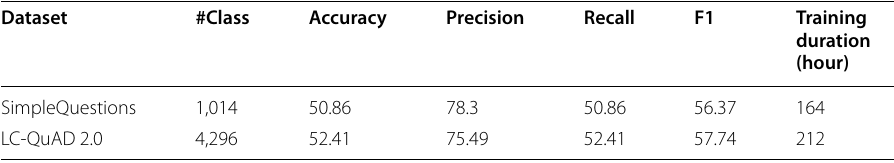
Table 6 The performance of entity detection task using POS tagging-based feature (in percent) Dataset #Class Accuracy Precision Recall F1 Training SimpleQuestions LC-QuAD